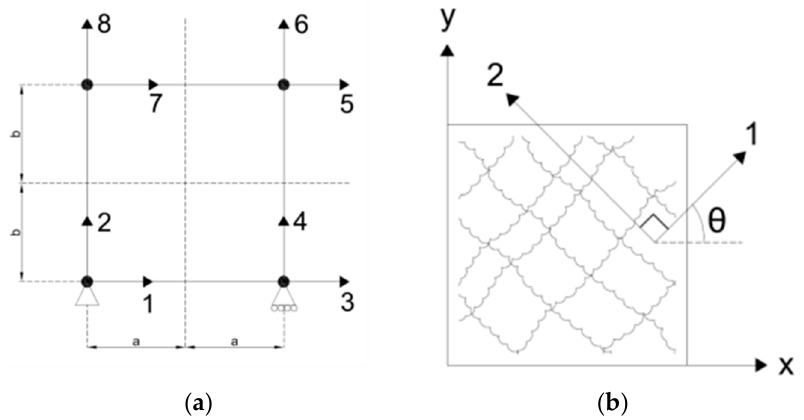
Figure 2. ( a ) Bilinear rectangular element, dimensions, DOFs and boundary conditions. ( b ) Element coordinate systems.